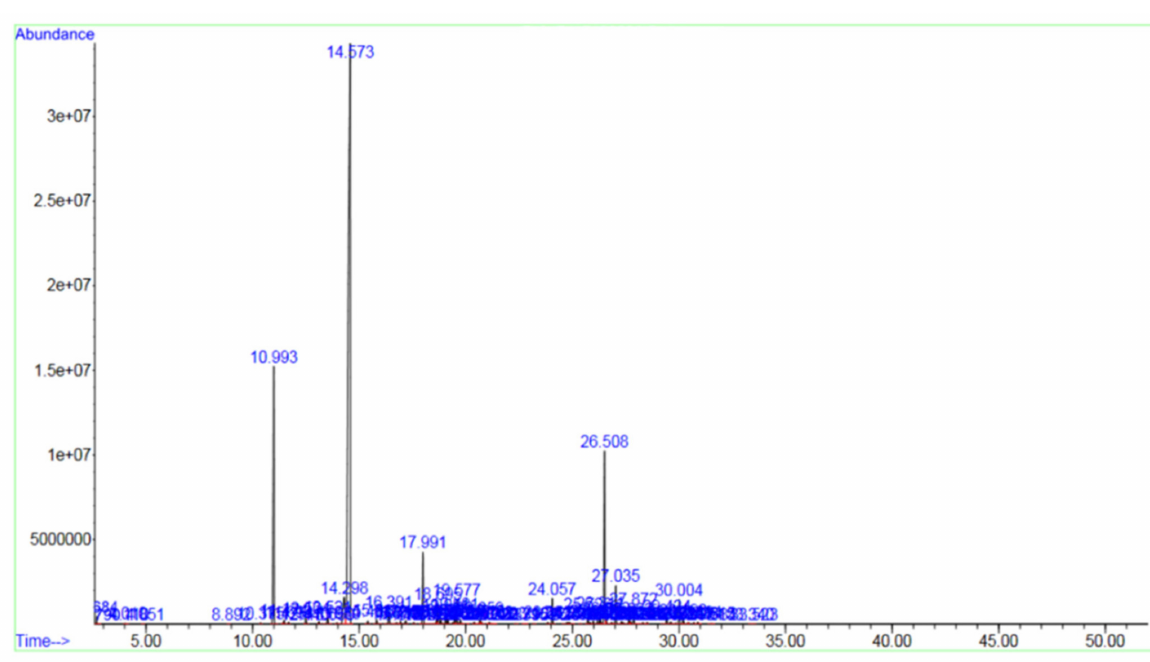
Figure A1. GC-MS chromatogram of the